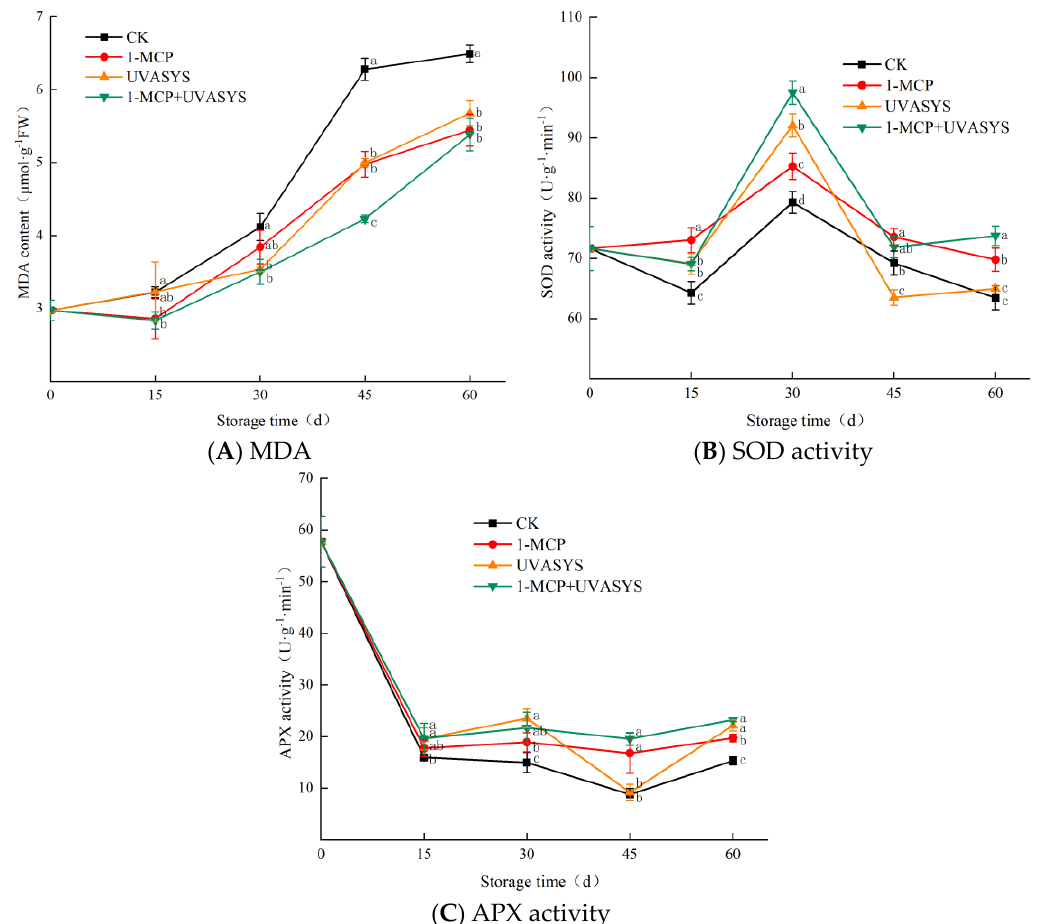
Figure 6. Effects of 1-MCP and UVASYS on MDA ( A ), SOD ( B ) and APX ( C ) of bamboo shoots during storage. Each data point represents an average ± standard error ( n = 3). Different letters indicate significant differences among treatments for each sampling time at p < 0.05.